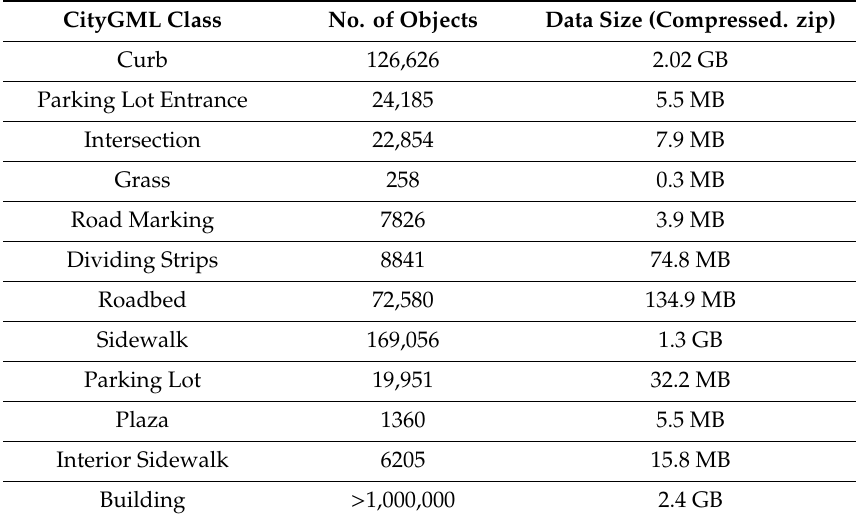
Table 3. Summary of all CityGML objects